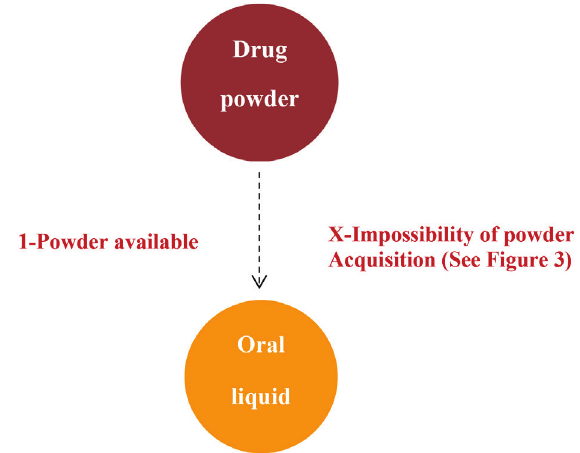
FIGURE 2 - Preparation of the oral liquid formulation from drug powder.